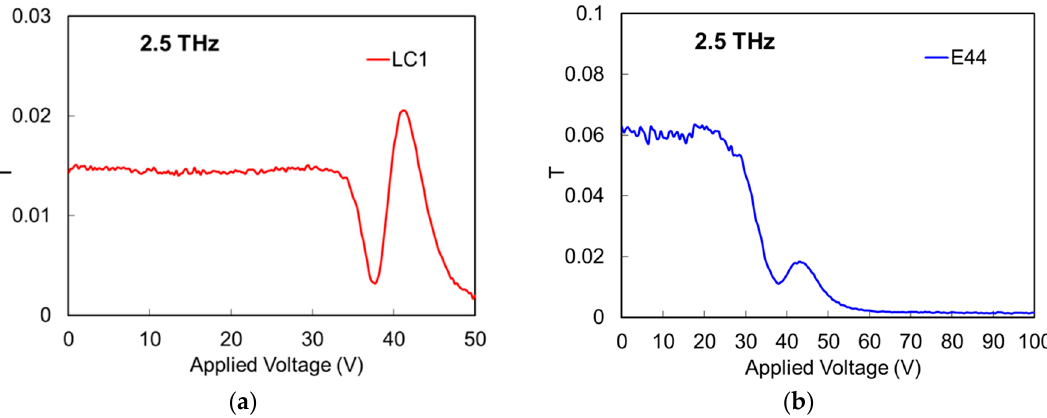
Figure 5. Transmitted terahertz intensity of ( a ) a hydrogen-bonded liquid crystal (LC1) and ( b ) a standard nematic LC (E44) as a function of the applied voltage.